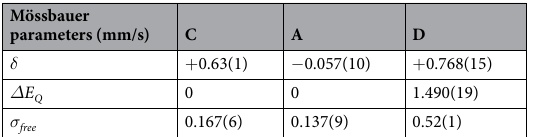
Mössbauer parameters (mm/s)